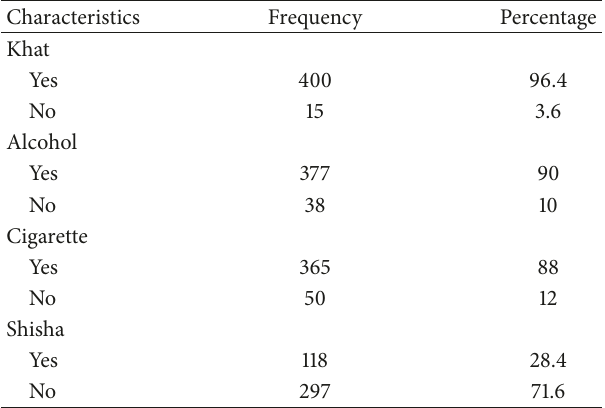
Table 2: Magnitude of other substances use in the last three months among the respondents at Shashemene Town, Oromia Region, Ethiopia.